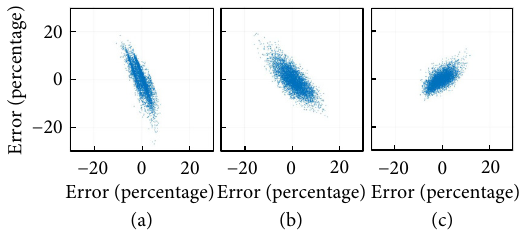
Fig. 13 Federated learning errors of currents’ real parts (x-axis) and imagi- nary parts (y-axis) for microgrid 1’s ( a ) phase , ( b ) phase , and ( c ) phase .